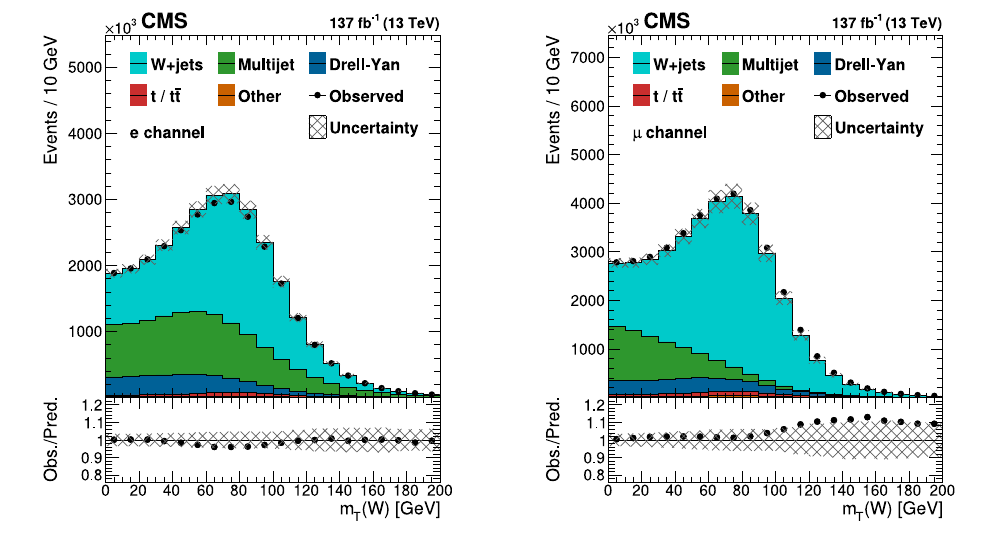
(W) multijet distribution in the selection with N Figure 3 . Fit result of the m T and tightly isolated electrons (left) and muons (right). The template obtained from the selection with loosely isolated leptons (green) and the total normalization of the electroweak and top quark background are floating in the fit. The lower panels show the ratio of the observed to the predicted event yields. The pre-fit systematic uncertainties are shown as a hatched